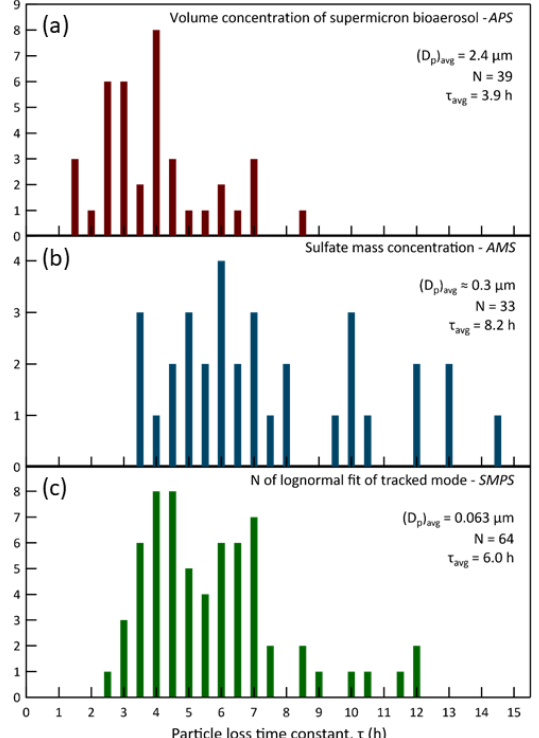
Figure 14. Exponential time constants for particle loss in the cham- bers during the 2016 study. Graph (a) presents the distribution of lifetimes of injected bioaerosol particles, which had an average di- ameter of 2.4µm. The loss rates were determined from exponen- tial decay fits to the supermicron volume concentration that was calculated from measurements by an APS. Graph (b) presents the distribution of lifetimes of 0.3µm diameter ammonium sulfate par- ticles intermittently injected to maintain a stable surface area con- centration in the chambers. The loss rates were determined from exponential decay fits to the sulfate mass concentration measured with an HR-ToF-AMS. Graph (c) presents the distribution of life- times of “tracked mode” particles having a study-average diameter of 0.063µm. The loss rates were determined from exponential de- cay fits to the number concentration parameter of lognormal fits to the narrow mode distributions measured with an SMPS. The y -axis values are the number of times the calculated loss rates fell within each 0.5h